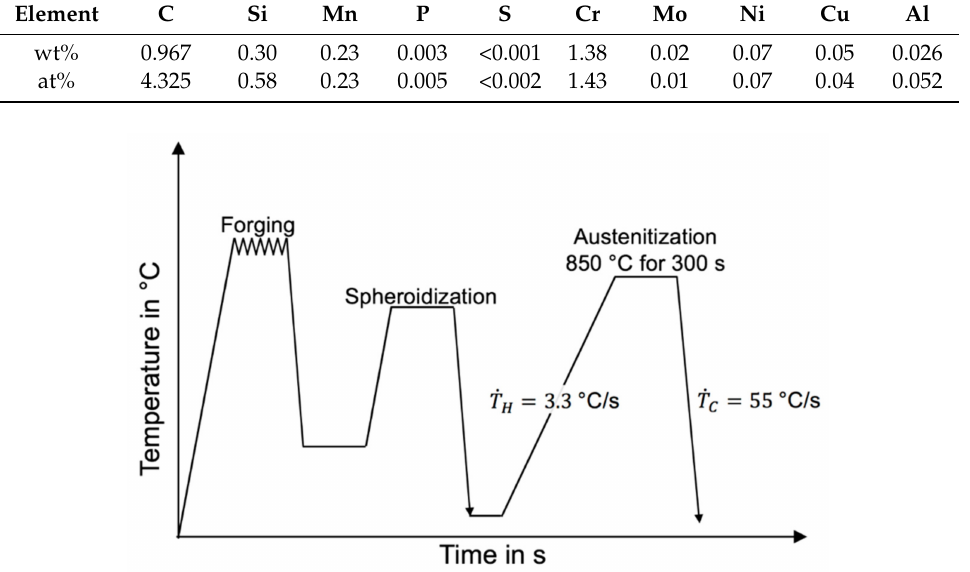
Figure 1. Heat treatment cycle of the investigated steel